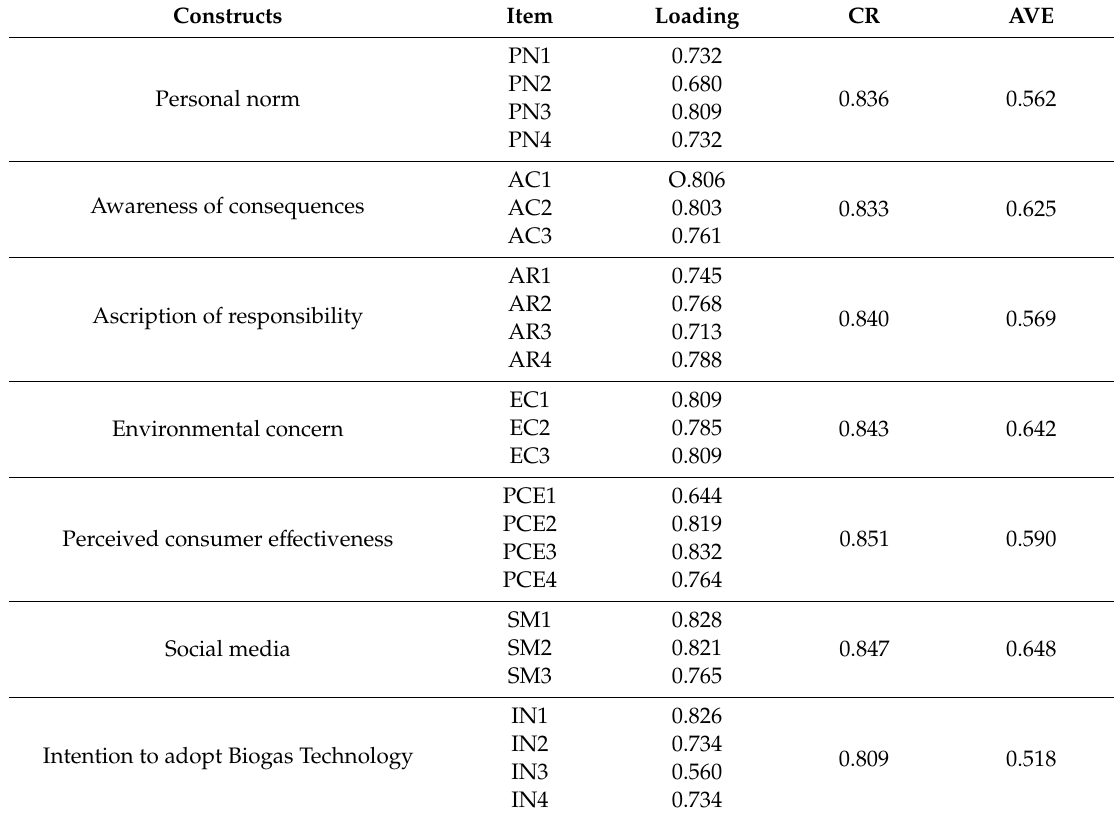
Table 2. Measurement model